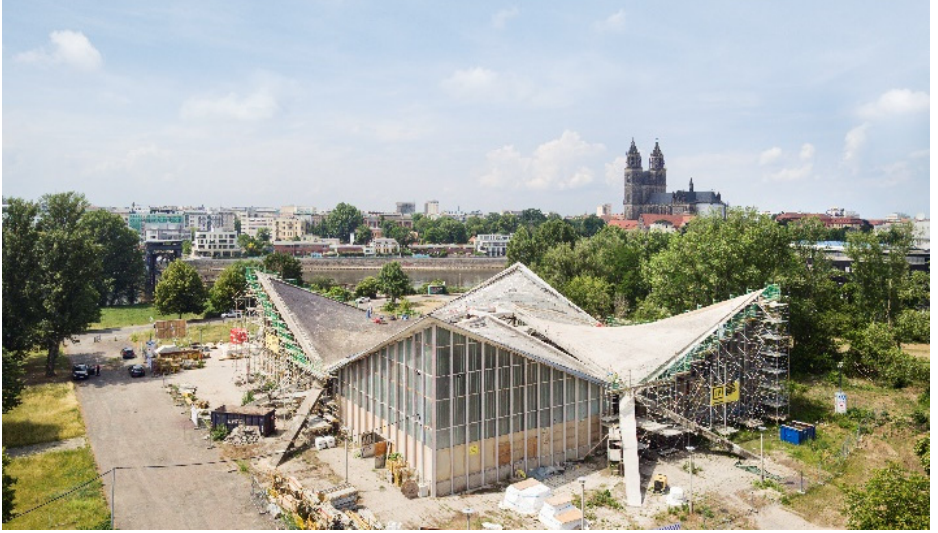
Figure 5. Strengthening process of the hypar shell in Magdeburg with CRC from 2020. (Photo: M. Bredt).